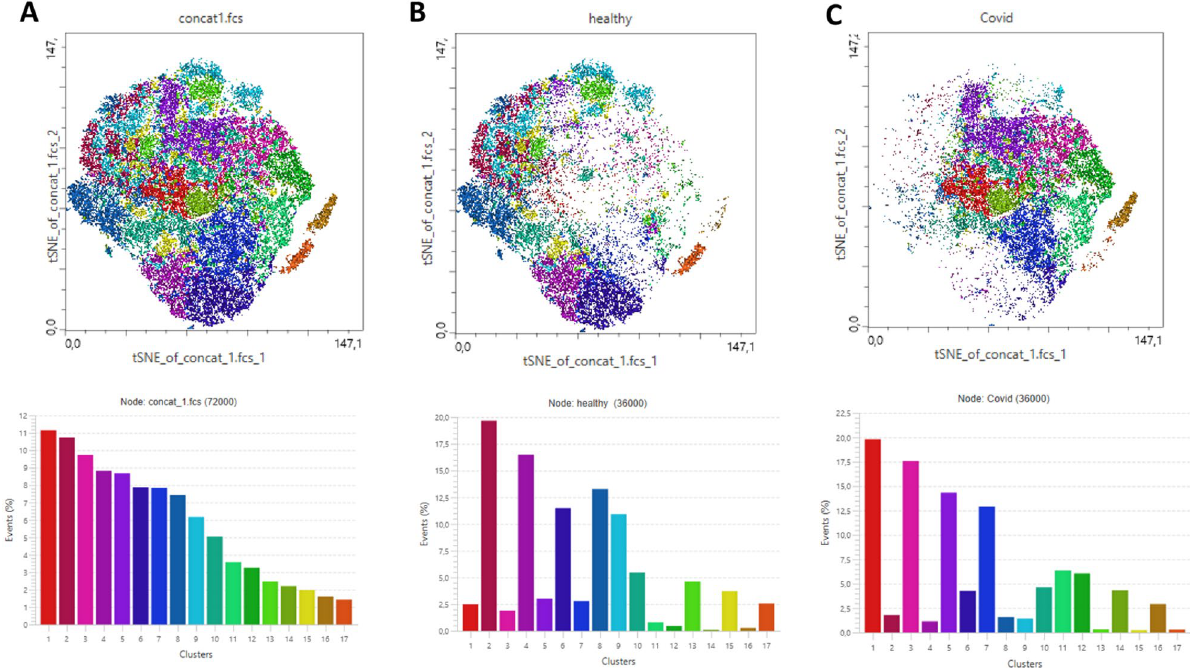
Figure 6. t ‐ SNE plots generated after data concatenation with hierarchical clustering of expression intensity (z score) for each of the indicated markers in each cluster derived using Phenograph. ( A ) Overview of all 17 clusters delineated within concatenated data for all analyzed samples. ( B ) Phenograph ‐ derived cluster pattern in healthy individuals. ( C ) Phenograph ‐ derived clusters pattern in COVID-19 patients. COVID-19 associated neutrophils were predominantly localized in clusters 1, 3, 5, 7, 10–12, 14 and 16. Neutrophils from healthy controls were grouped within clusters 2, 4, 6, 8, 9, 13, 15 and 17.